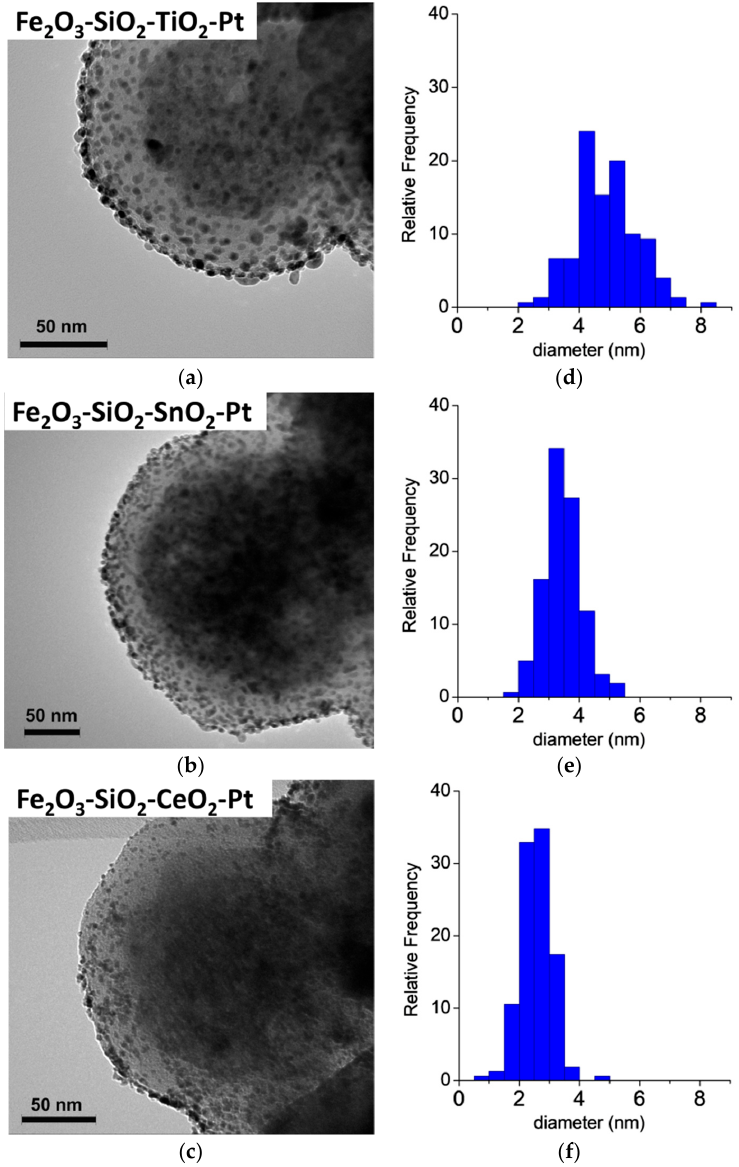
Figure 2. HR-TEM characterization for the synthetized Pt catalysts. ( a – c ) HR-TEM micrographs and ( d – f ) Pt particle size distribution. Table 1. ICP results, Pt mean particle size by HRTEM and surface area of Fe 2 O 3 –SiO 2 –Pt